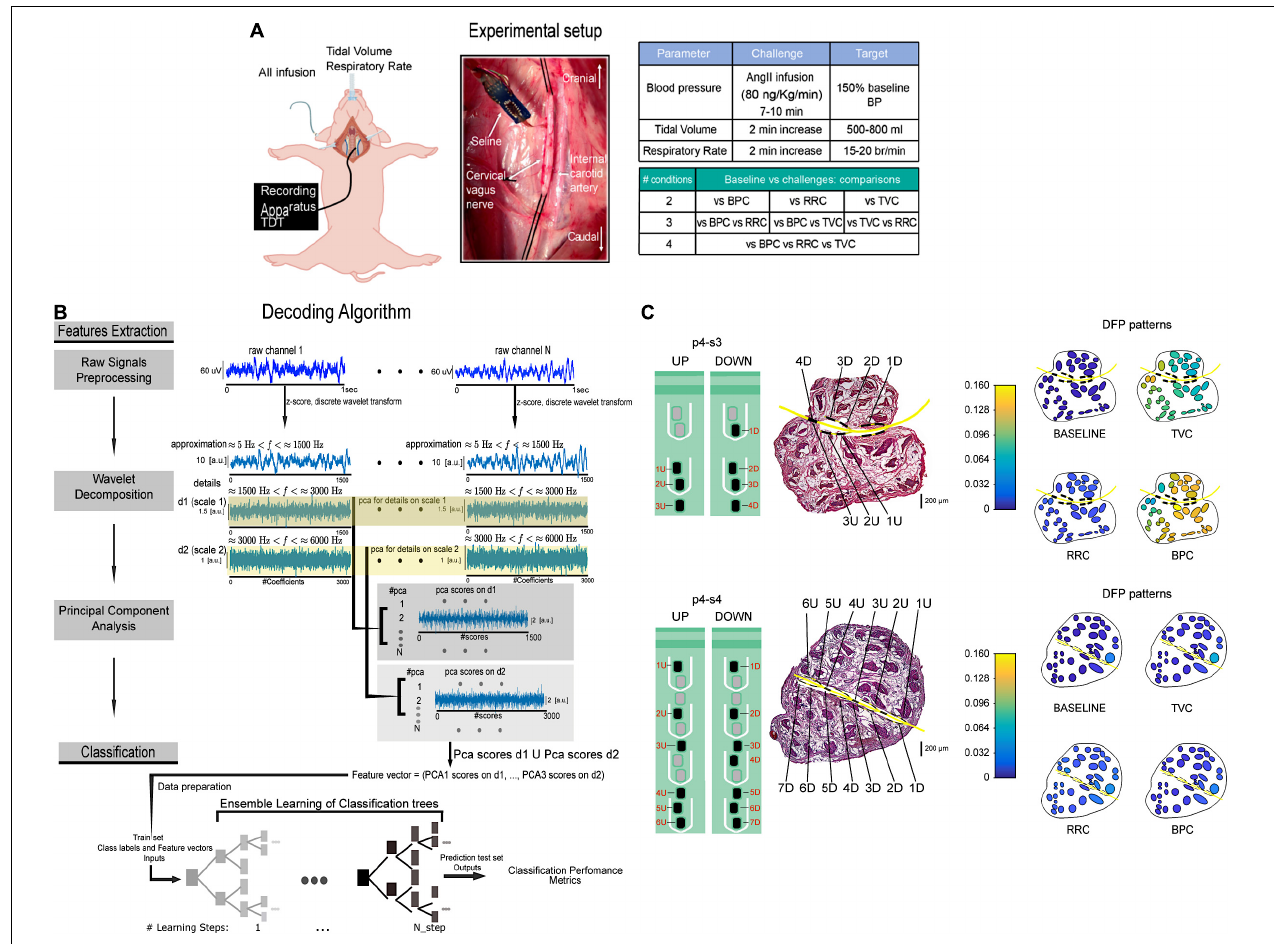
FIGURE 6 | Schematic representation of the experimental setup and decoding algorithm from Vallone et al. (152). (A) Recording apparatus, electrode implantation and summary of the in vivo protocol and functional challenges comparisons. (B) Decoding algorithm. Feature extraction was performed on 1 s portions of raw intraneural signals (dark blue traces) by applying principal component analysis on wavelet details relative to two different scales (1,500 Hz < f < 3,000 Hz and 3,000 Hz < f < 6,000 Hz). Neural signals recorded with intraneural electrodes were a combination of single-unit and compound action potentials. Decoding performed with ensemble learning based on classification trees combined with random undersampling and boosting procedure was applied on feature vectors. Decoding performance was assessed by means of confusion matrices and accuracy level. (C) Schematic description of two intraneural electrodes implantation in the VN of one pig and hybrid model simulations of fascicles activation at baseline and in response to functional challenges. The two intraneural electrodes are represented on a VN histological section (central panels). DFP patterns of activity during baseline and each functional challenge (left panels). DFP, discriminative field potentials. Adapted from Vallone et al. (152) with